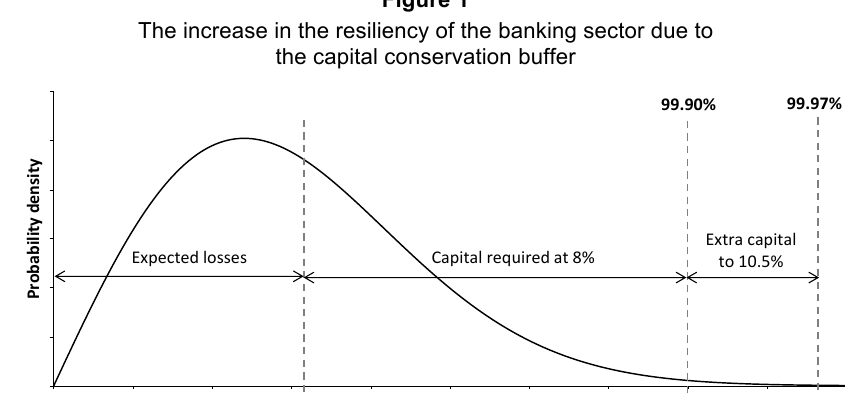
The increase in the resiliency of the banking sector due to the capital conservation buffer